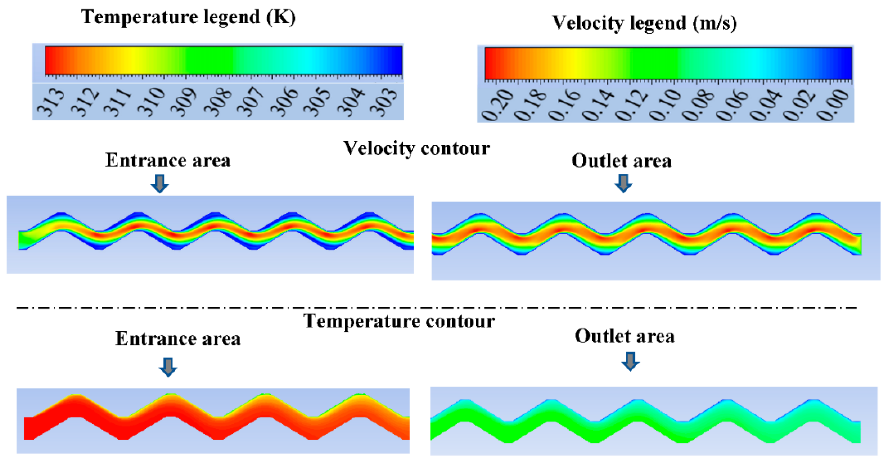
Figure 7. The numerical section of study (test) with the temperature and velocity profiles at the entrance and outlet of the channel.